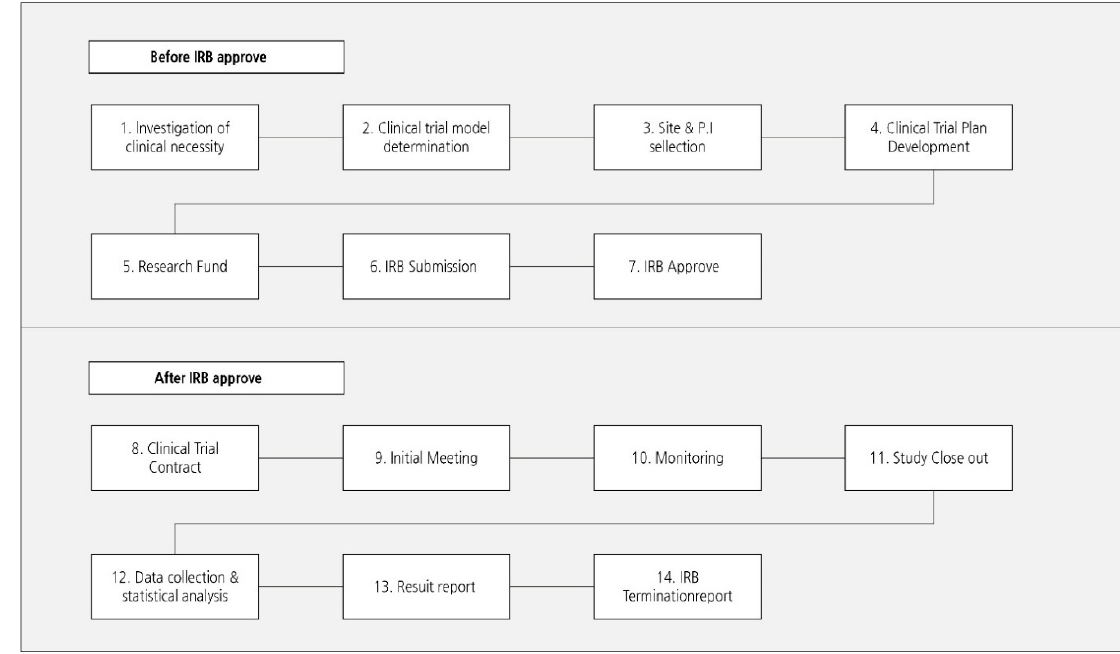
Figure 2. Clinical trial of the computer-based dementia assessment contents (Co-Wis).